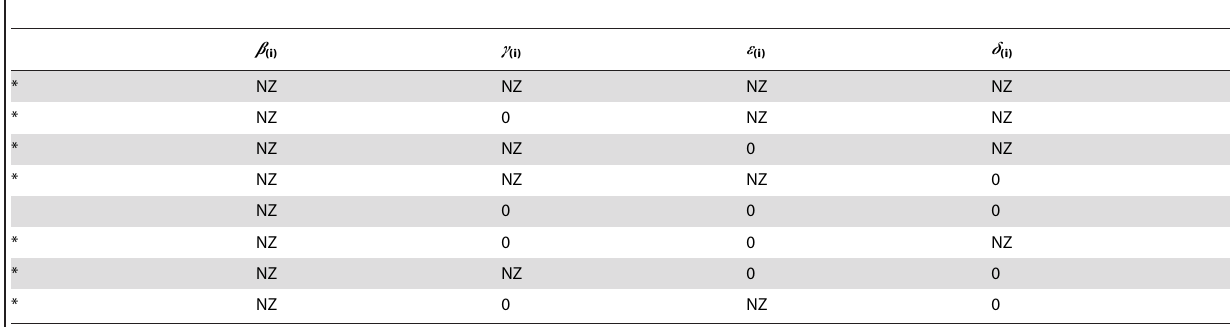
Table 1. Combination of zero and non-zero values of c (i) , e (i) and d (i) in Eqn